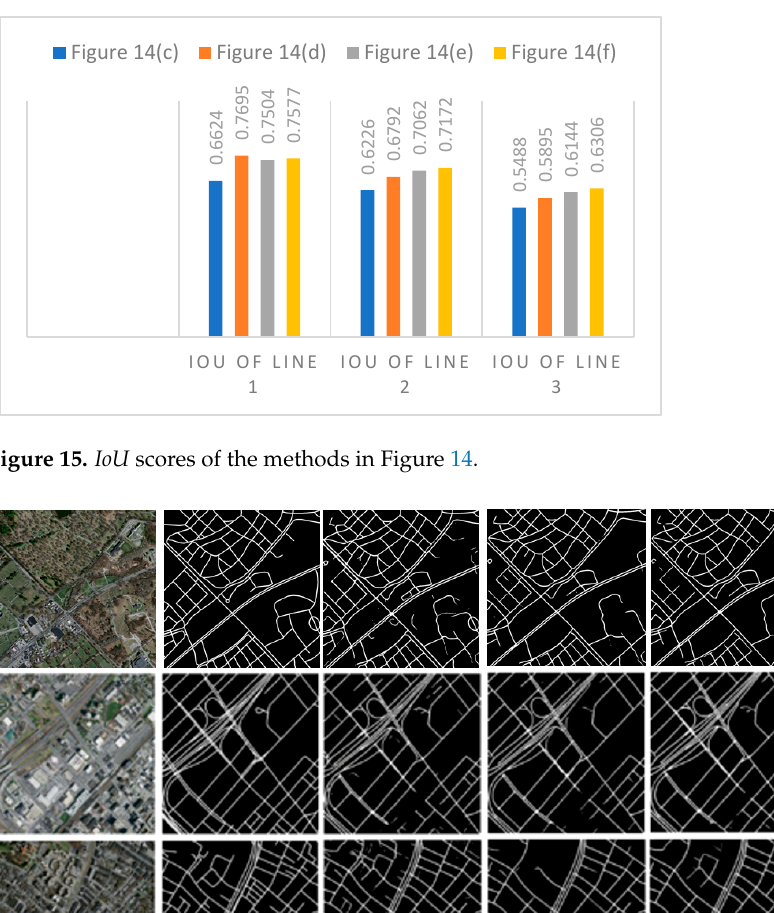
Figure 14. Road extraction results in general scene images; ( a ) input image; ( b ) label image; ( c ) D- LinkNet; ( d ) S-DenseNet; ( e ) SD-DenseNet; ( f ) SDG-DenseNet.